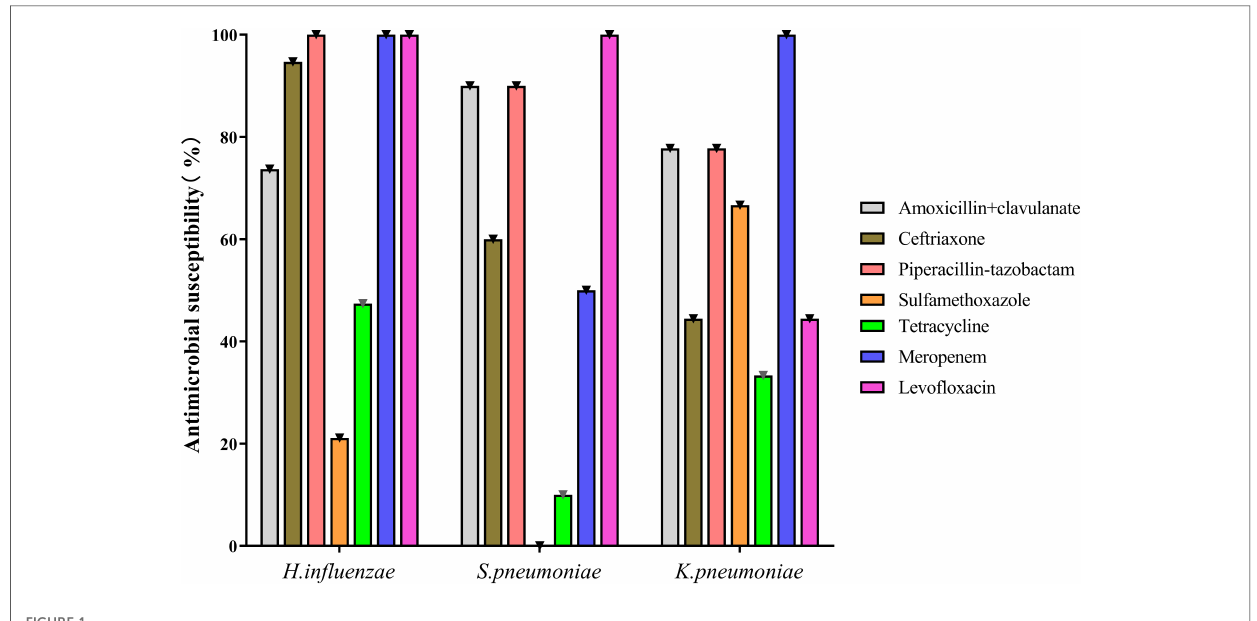
FIGURE 1 In vitro antibiotic sensitivity of H. in fl uenzae , S. pneumoniae , and K. pneumoniae .